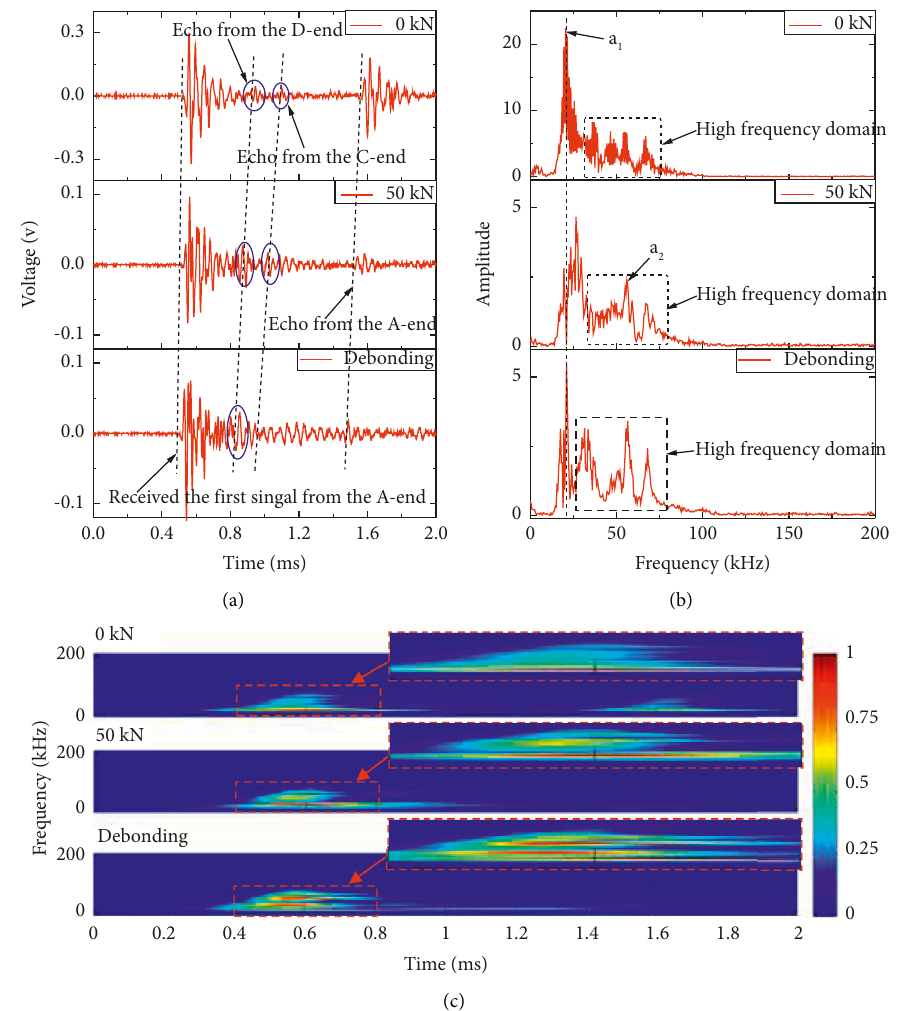
Figure 3: The wave propagation signal received at the F-end under pullout load, (a) Time domain; (b) frequency domain; (c) time-frequency domain.